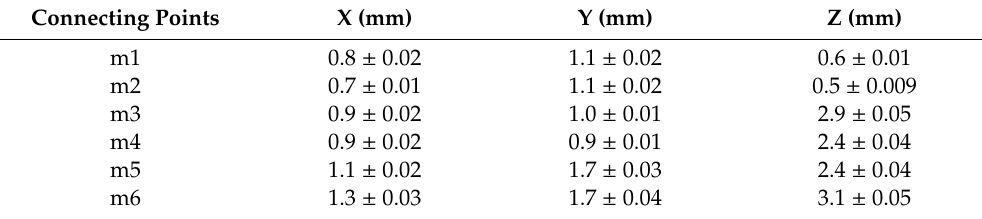
Table 3. RMSE values during the second test (roll angle following a sinusoidal time law) computed from data measured by the DORIS platform and by the cameras system. Mean value for each axis ± standard error.